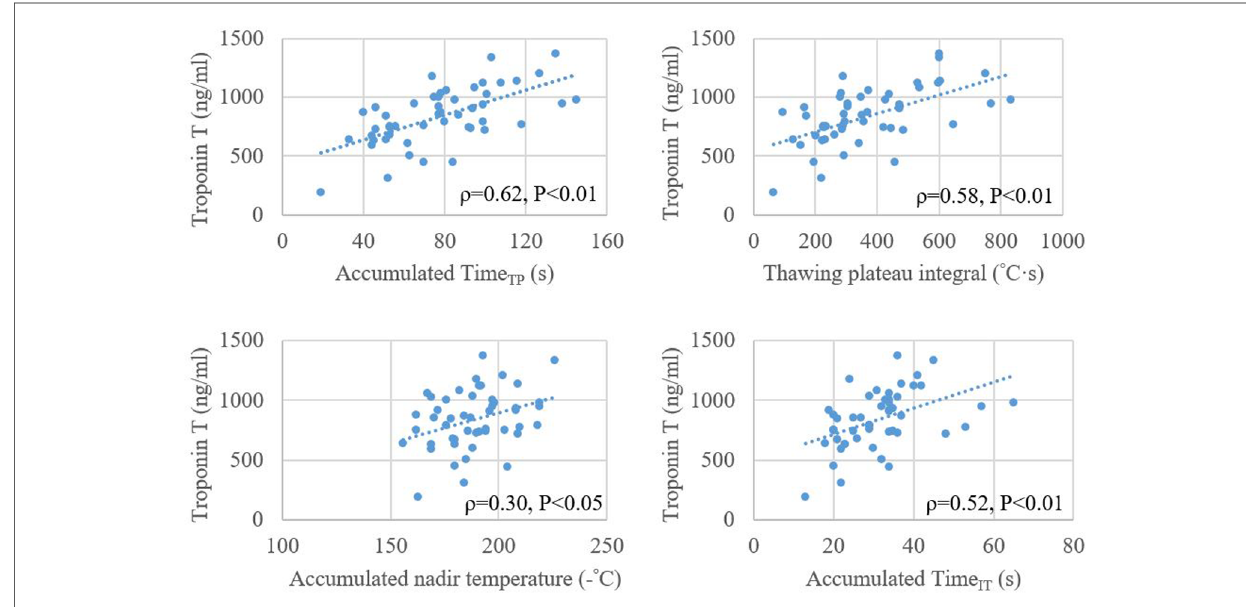
FIGURE 4 Relationship between plasma level of troponin T after cryoballoon ablation and accumulated values of time TP , thawing plateau integral, nadir temperature, and time IT . Time IT , initial thawing time; Time TP , thawing plateau